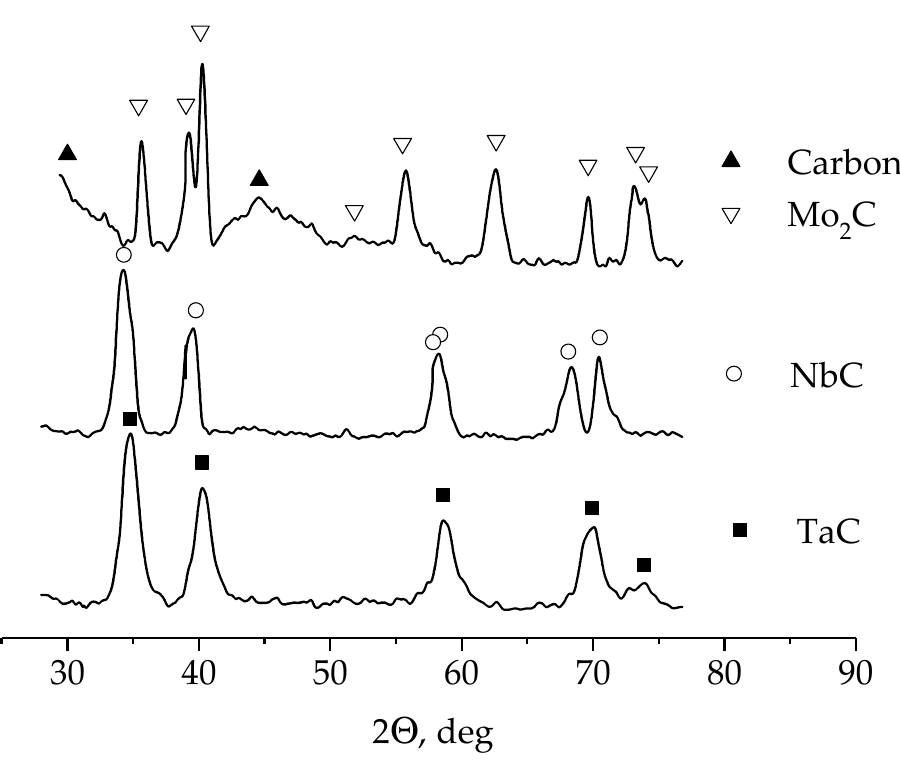
C crystals obtained by electro- 2